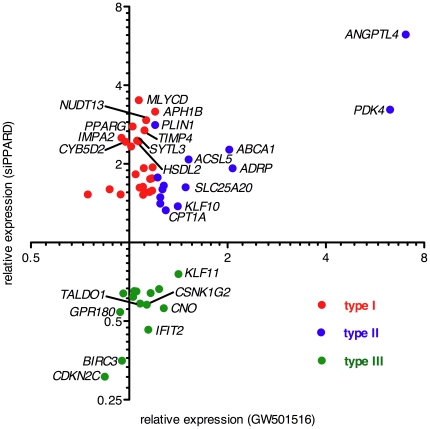
Correlation of PPARD siRNA and GW501516 mediated gene regulation for the validated gene set.Red: type I response, upregulated (≥1.5-fold) by PPARD siRNA and unaffected by GW501516; blue: type II response, upregulated by PPARD siRNA and induced by GW501516 (≥1.2-fold); green: type III response, down-regulated (≥1.5-fold) by PPARD siRNA. Each data point represents the average of 4 biological replicates as in Figure 3A–C.